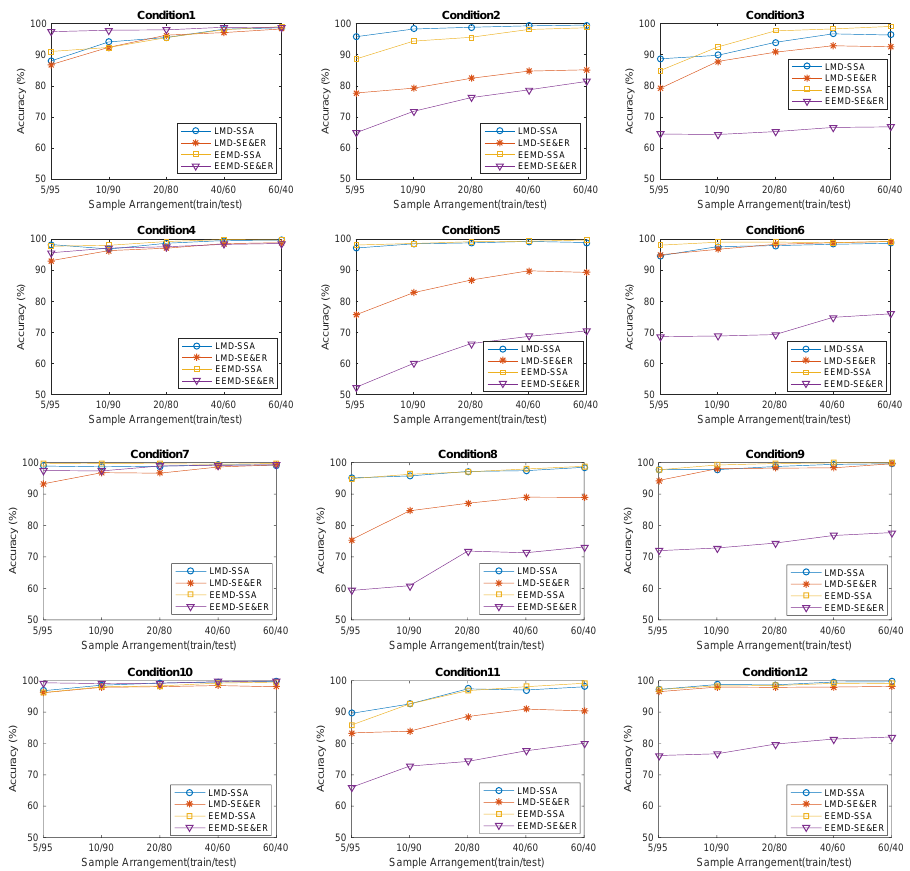
Figure 7. Average diagnostic accuracy to all independent experiments corresponding to 12 different working conditions, respectively, with different schemes in the 1st – 4th experimental sets.